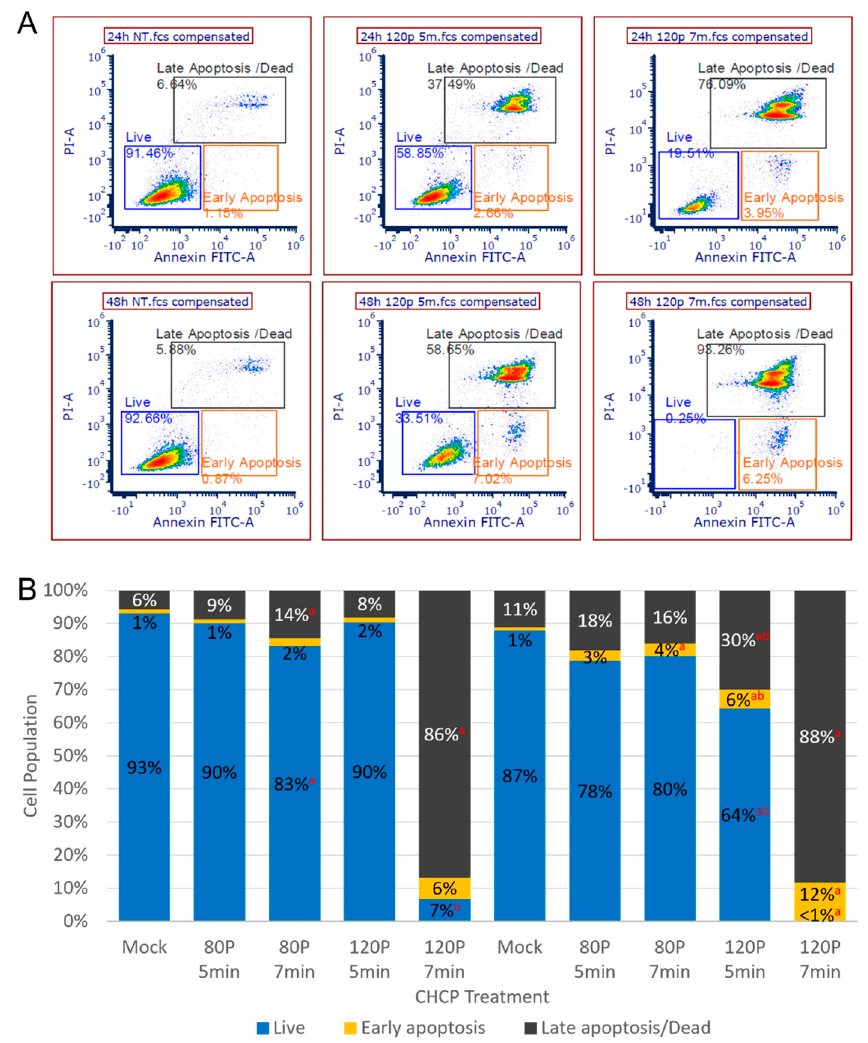
Figure 5. Distribution of cell population in live, early apoptotic, or late apoptotic/dead stages 24 ‐ or 48 ‐ h post ‐ CHCP treatment presented in ( A ) flow cytometry images and ( B ) a bar graph. Statistical significance for CHCP versus mock controls ( a p ≤ 0.05) and 24 ‐ versus 48 ‐ h post ‐ CHCP treatment ( b p ≤ 0.05) were considered.